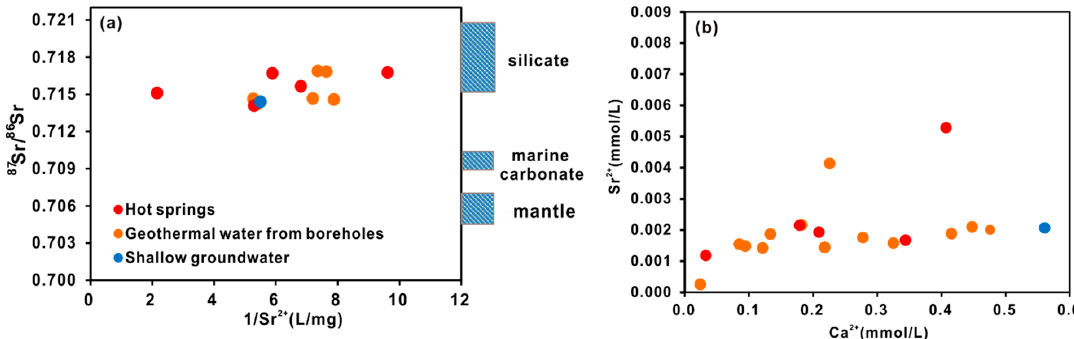
Figure 8. ( a ) The diagram of 87 Sr/ 86 Sr ratio vs 1/Sr 2+ for waters from Ganzi. The 87 Sr/ 86 Sr ratios of marine carbonates range from 0.707–0.709 [49–51]. The 87 Sr/ 86 Sr ratios of the silicate rocks in the Yangtze valley in China are usually >0.715, as referenced from Wang et al. (2007) [52]. The 87 Sr/ 86 Sr ratios of the mantle are 0.702–0.705 [46], ( b ) Sr 2+ vs Ca 2+ plot.